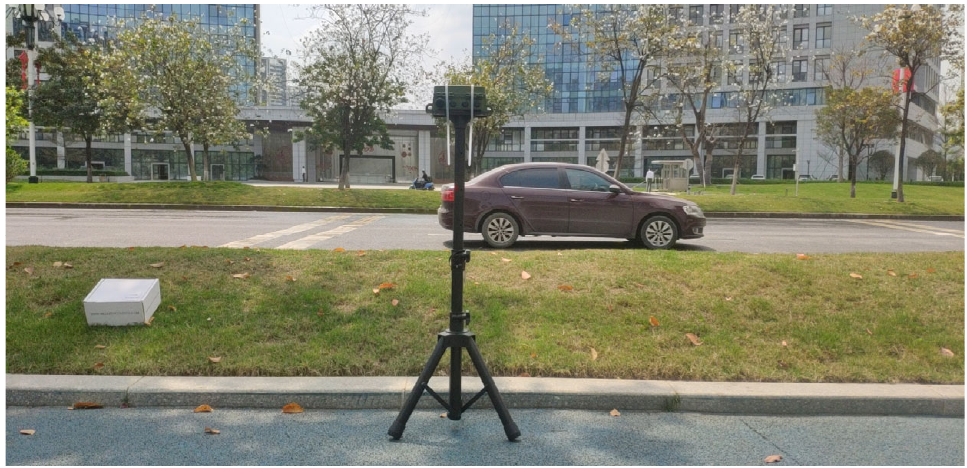
Figure 1. Recording